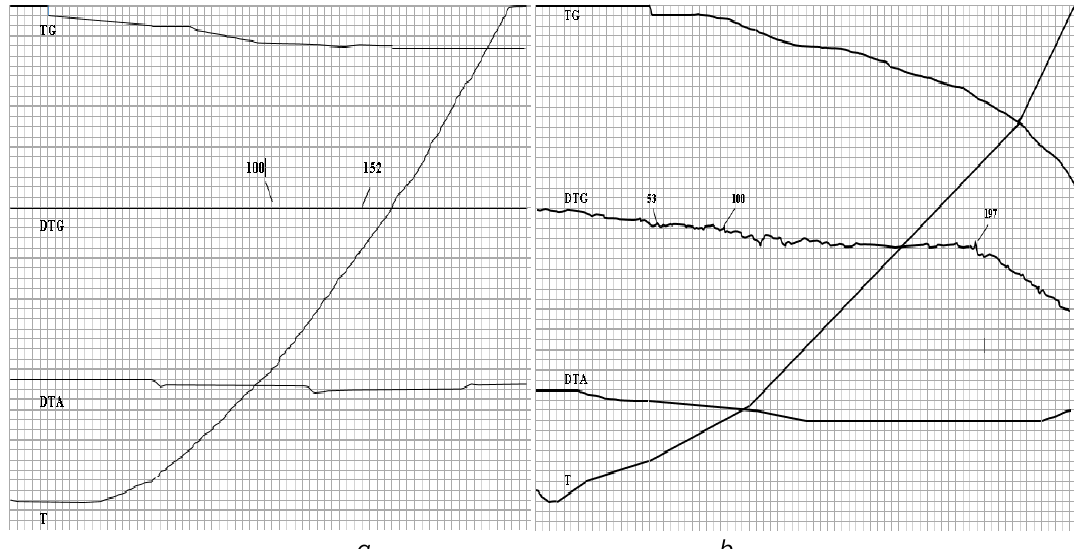
Fig. 3. Derivatographic research of substances: a – diosmin; b –